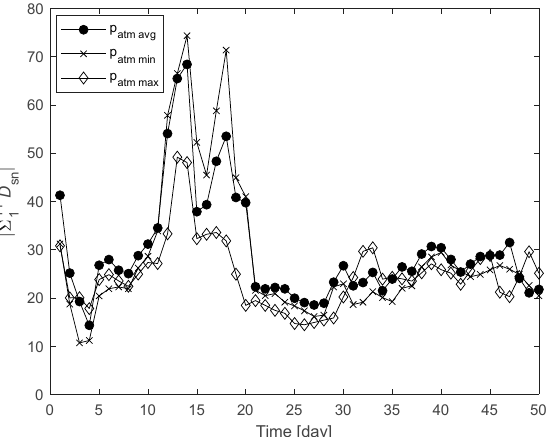
Figure 8. The variation of the classification potential ( D sn values) of the daily minimum, maximum and average values of atmospheric pressure. Day 1 is the beginning of the growing season.